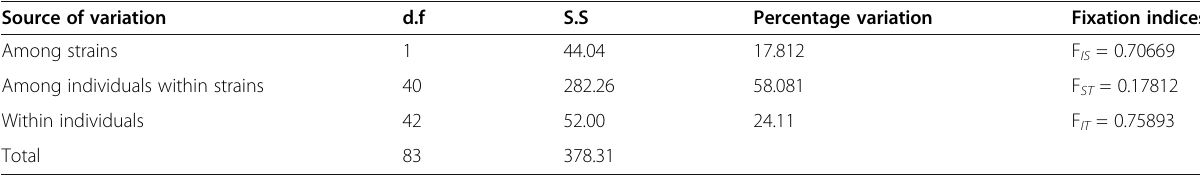
Table 7 ANOVA analysis of jumbo and gray Japanese quail strains based on microsatellite DNA variation Source of